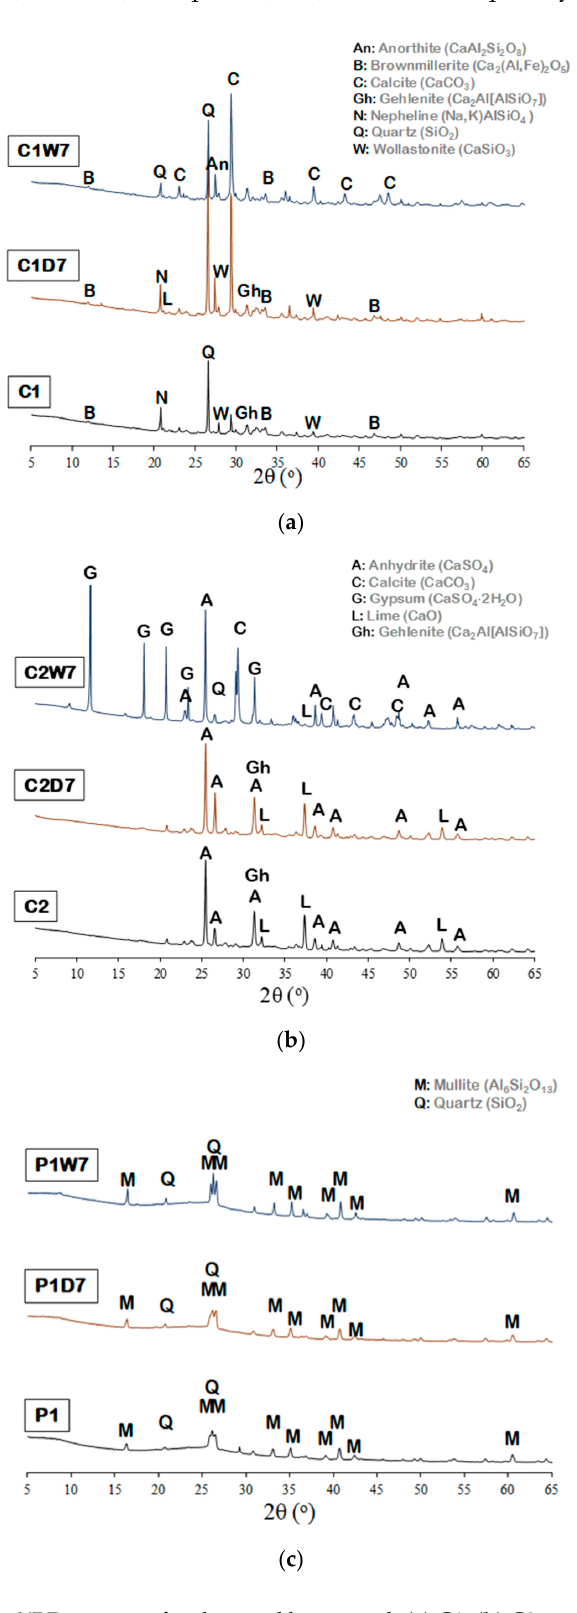
Figure 3. XRD pattern of carbonated bottom ash ( a ) C1; ( b ) C2; and ( c ) P1.